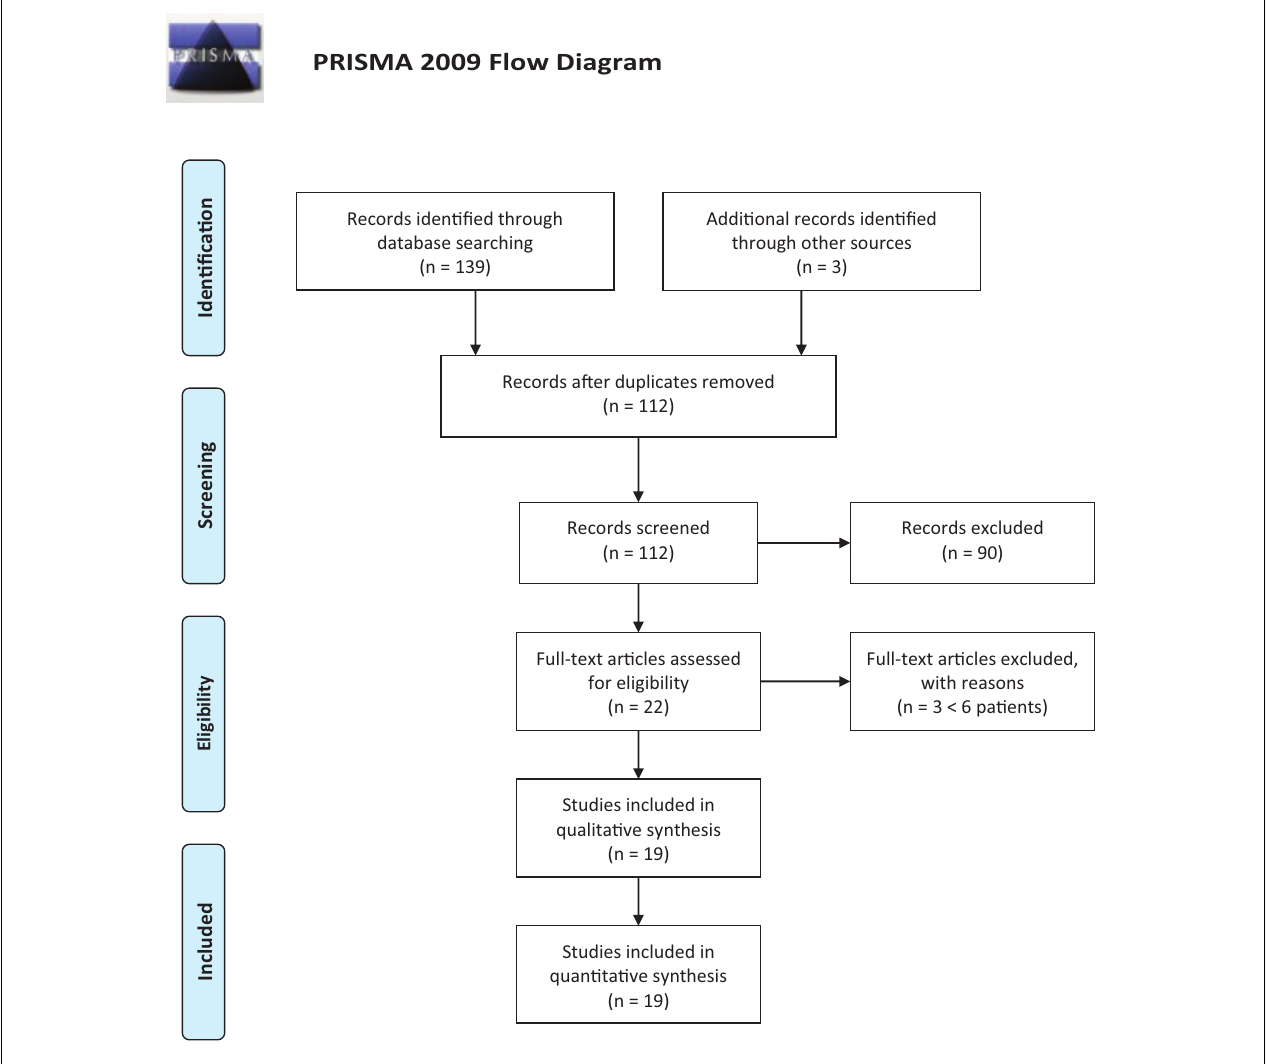
FIGURE 1 | PRISMA flow